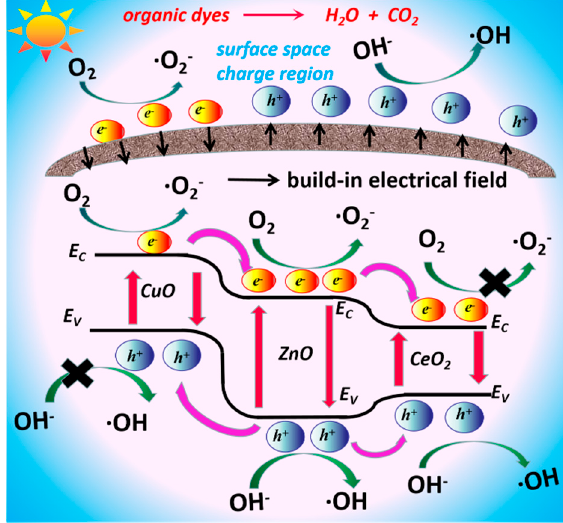
Figure 9. Graphical illustration of photo-degradation mechanism of CuO/CeO 2 /ZnO ternary